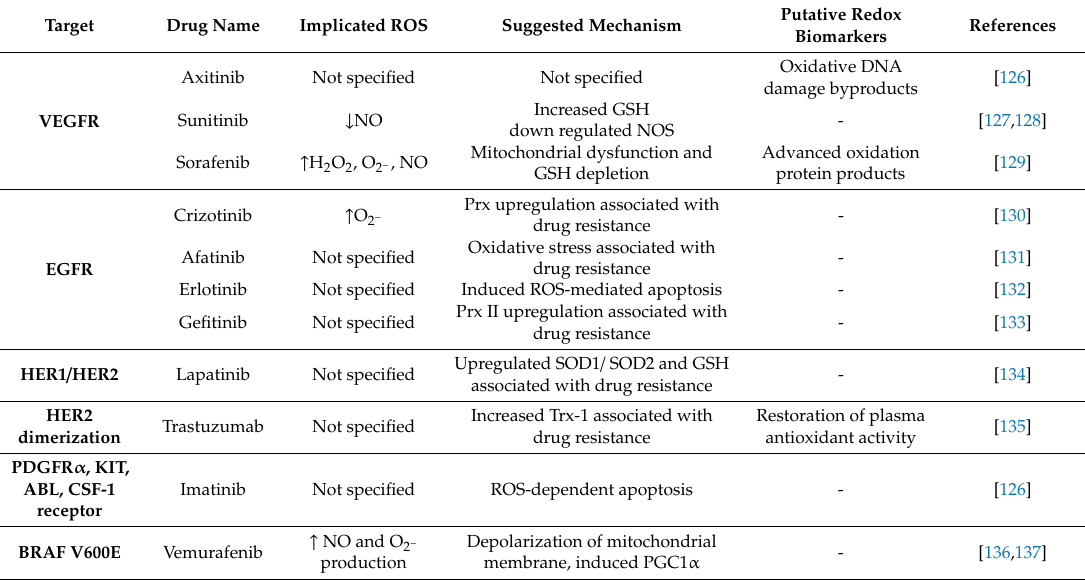
Table 1. Reactive species-mediated e ff ects of receptor-targeted